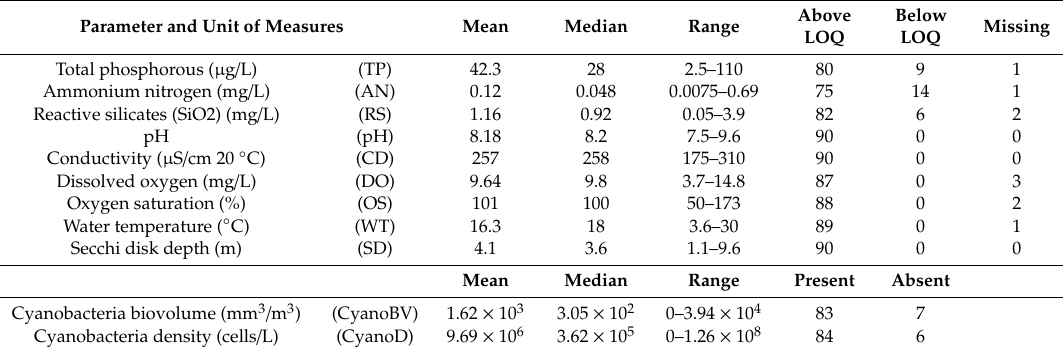
Table 1. List of water surface physical–chemical variables and total cyanobacteria biovolume / density measured at Lake Varese during the period 2004–2014. The mean, median, and range (minimum–maximum) values are reported for each variable. The number of samples above and below the level of quantification (LOQ), and missing values are reported. The number of cyanobacteria (present / absent) over the total sampling campaigns is